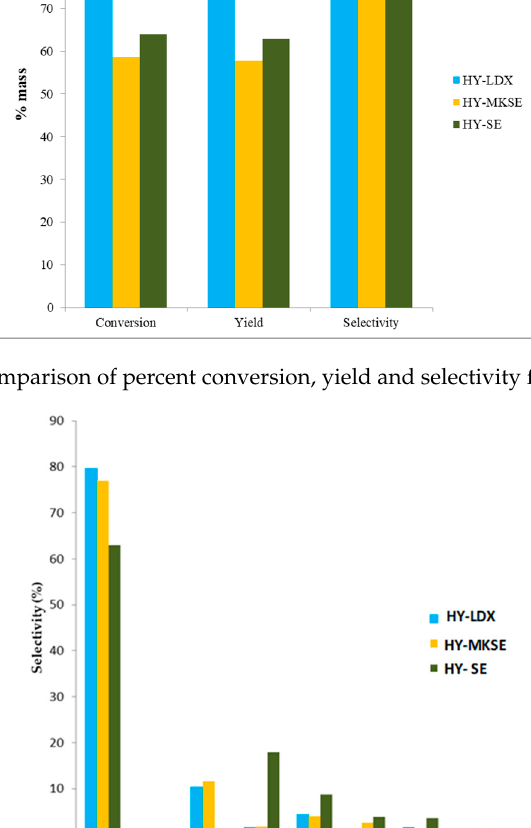
Figure 15. A comparison of the percent selectivity on gasoline products.